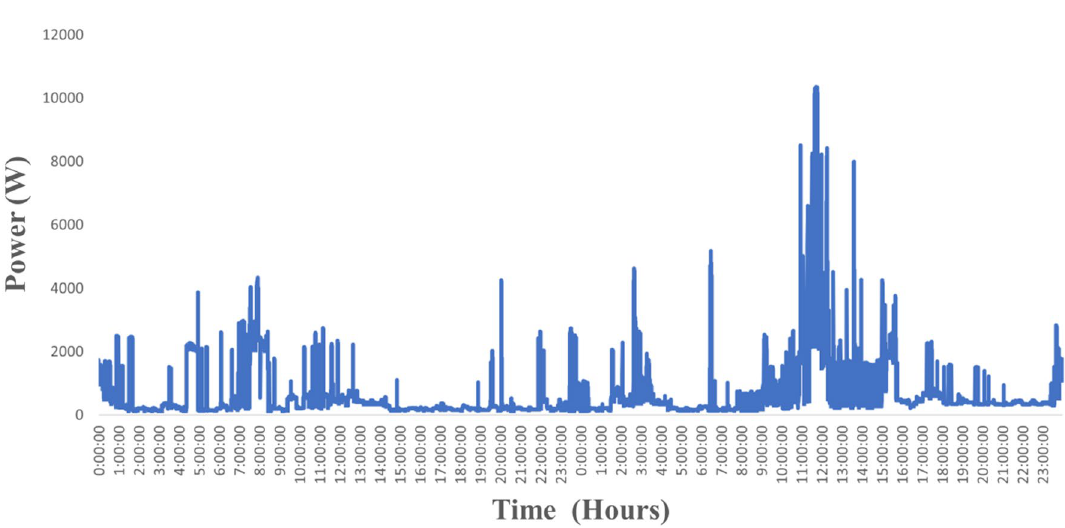
Figure 6. Aggregate Power consumption of a